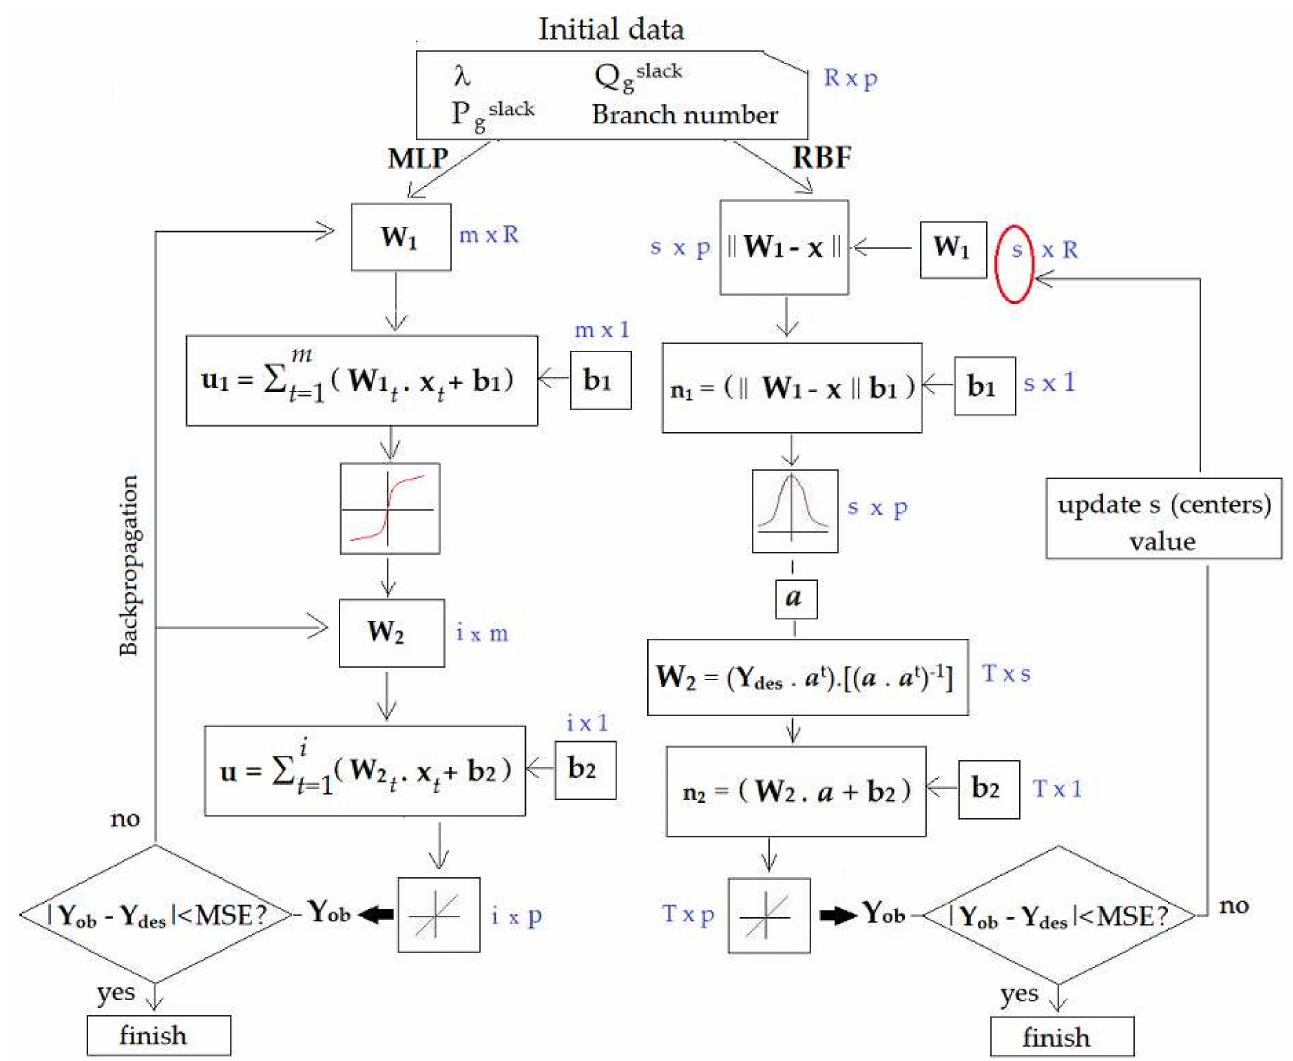
Figure 3. Flowchart of the MLP and RBF networks used in this